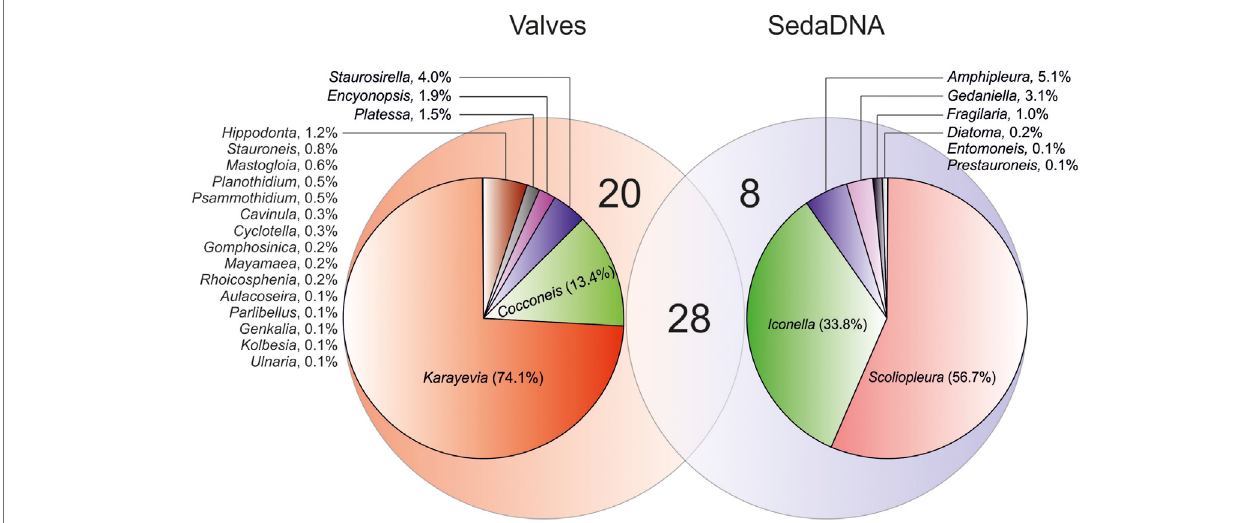
FIGURE 6 | Venn diagram for shared and unique diatom genera identi fi ed in valves and sedaDNA data sets. There was a total of 28 shared genera between data sets, but 20 and 8 unique genera for valves and sedaDNA data set, respectively. Pie charts represent the proportion of valves/sequences of the genera that are unique per data set (i.e., only identi fi ed in valves or sedaDNA data set).